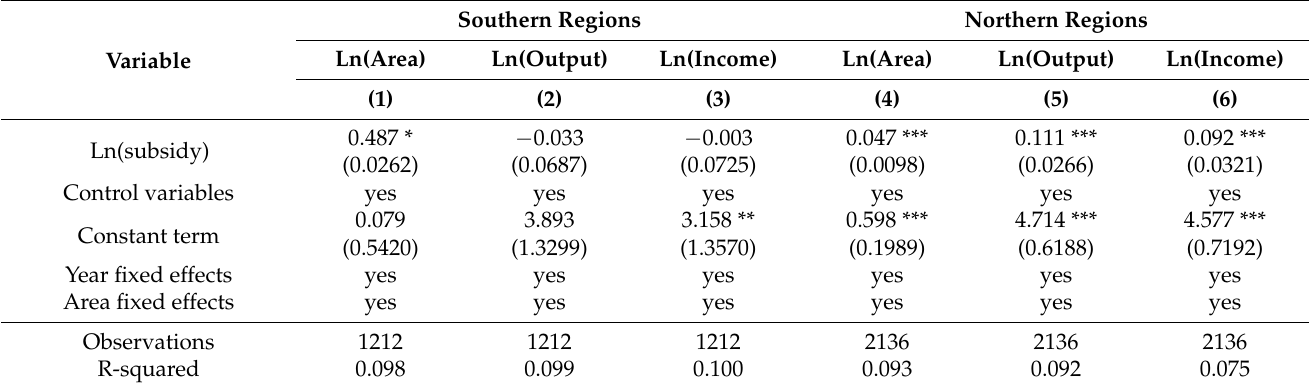
Table 5. Estimated results of distinguishing northern and southern